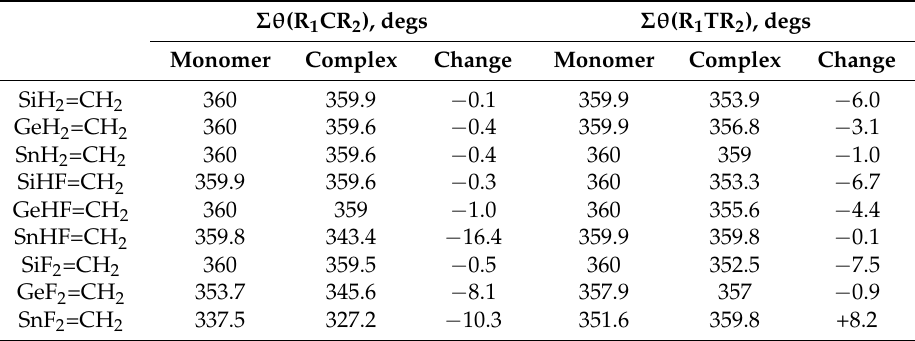
Table 8. Planarity measure of TR 2 =CH 2 molecule in its geometry within the monomer and its π -bonded c complex with NH 3.